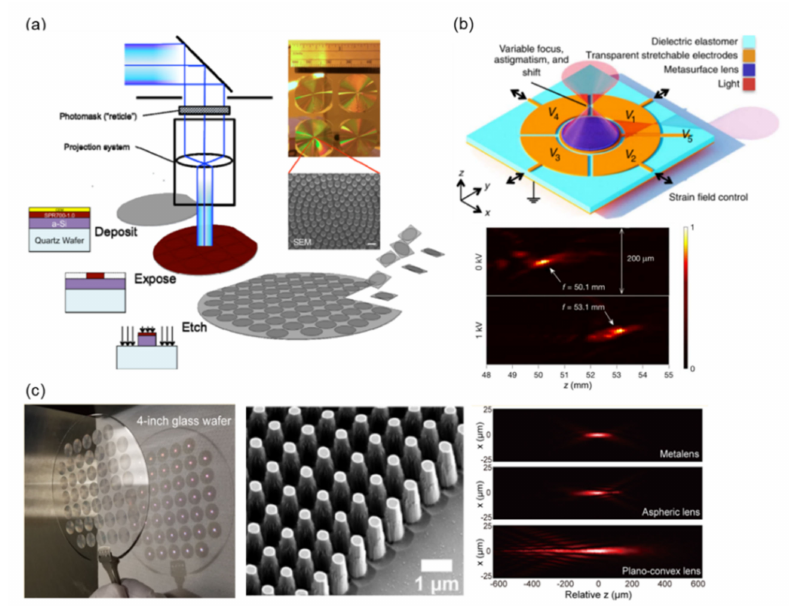
Figure 7. ( a ). Metalens production using photolithographic stepper technology [185]. ( b ) Tunable metalens device (top), in which the focal length of the metalens is controlled using DEAs; intensity profile (bottom) along the z -axis with and without voltage bias [183]. ( c ) A photograph (left) and SEM images (middle) of metalenses on a 4-inch glass wafer. Comparison of measured light intensity distributions (right) of the focal spot of a fabricated metalens and commercial plano-convex lens, respectively